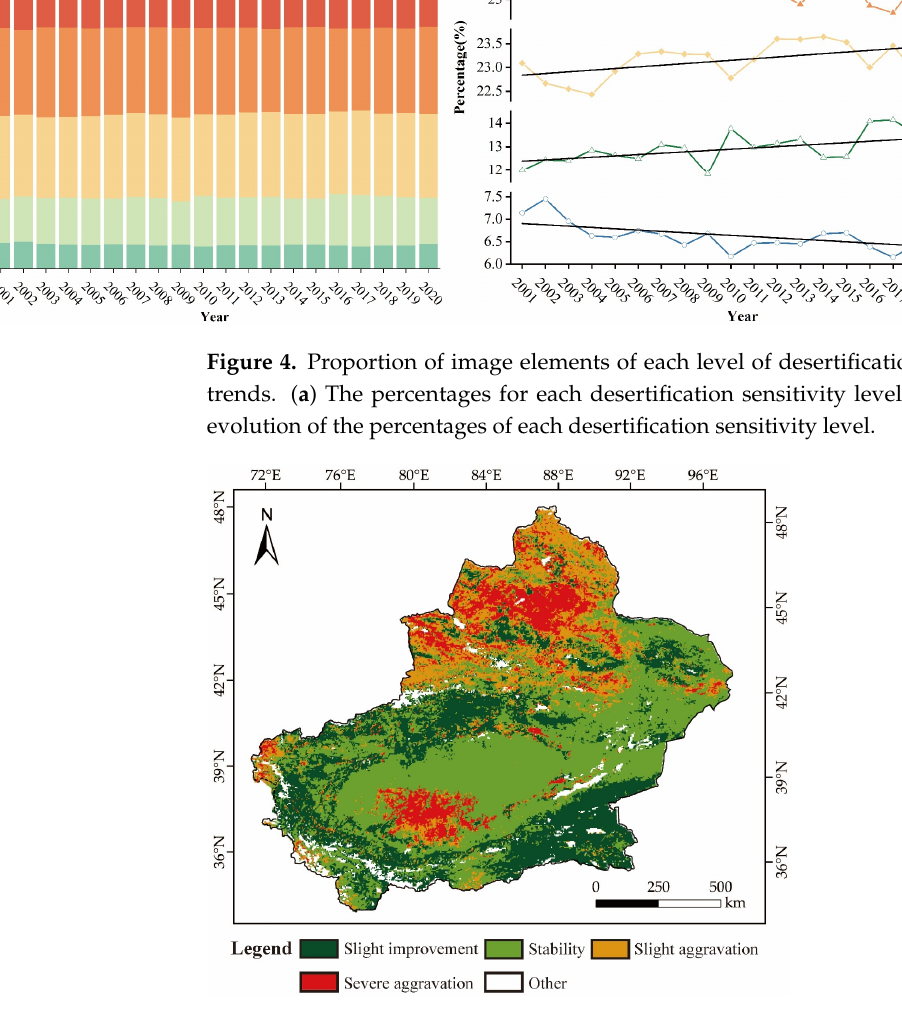
Figure 5. Spatial distribution of multi-year deserti fi cation sensitivity trends.